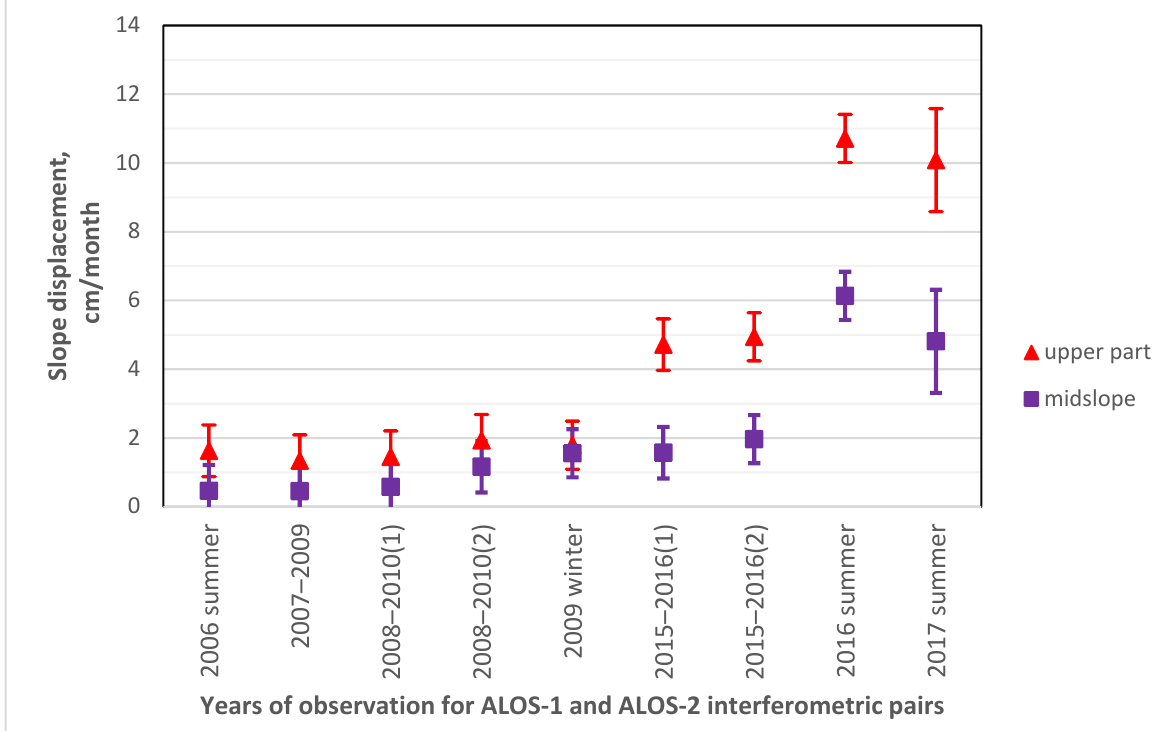
Figure 10. Slope displacements along the landslide slope surface derived from PALSAR (2006–2010) and PALSAR-2 (2015–2016) interferograms.